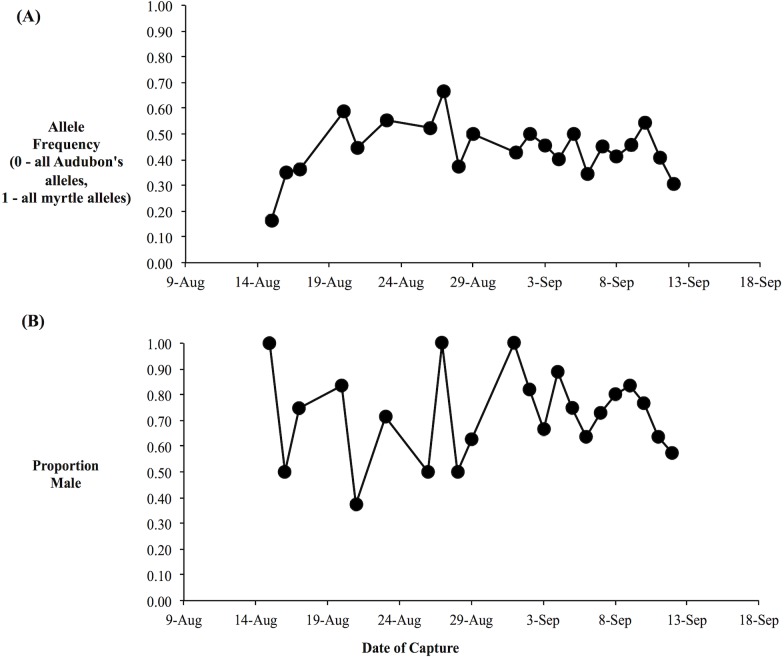
Average hybrid index and sex proportion is relatively constant over the migratory period.(A) Average hybrid index over the fall migratory period. Hybrid index was based on three nuclear genetic markers and was equivalent to the proportion of myrtle alleles (i.e., 0, all Audubon’s alleles; 1, all myrtle alleles). (B) Proportion of daily sample that were male, as determined by molecular sexing.